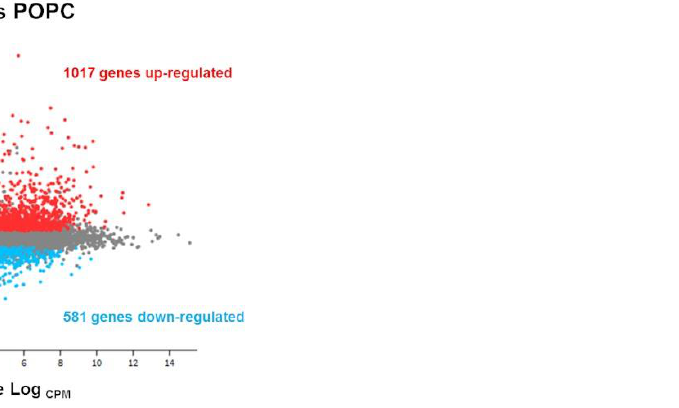
Figure 2. POPC liposomes significantly modify peritoneal cell transcriptome. CD-1 mice ( n = 3 per group) were injected with POPC liposomes (400 µ g) or an equal volume of PBS (carrier). Peritoneal cells were collected 1 h after the injection and processed for RNA isolation and RNA-seq analysis. The Glimma plot showing the differential gene expression between cells treated with POPC liposomes and PBS is presented, displaying the log-fold-change vs. average expression for each gene. Genes up-regulated in POPC liposomes vs. PBS are shown as red dots, while genes that are down-regulated in POPC liposomes vs. PBS are depicted as blue dots. A total of 1017 genes were up-regulated by POPC treatment, whereas 581 genes were down-regulated after POPC exposure. Signaling pathway impact analysis (SPIA) revealed that 24 signaling pathways were significantly activated or inhibited after exposure to POPC liposomes (pGFdr < 0.2; Table 1). Among these pathways, activation of the KEGG NF- κB pathway, in which 29 genes were upregulated after POPC liposome treatment, showed the highest statistical signifi- cance (pGFdr = 2.81 × 10 −9 ; Figure 3). Table 1. Signaling Pathway Impact Analysis (SPIA).